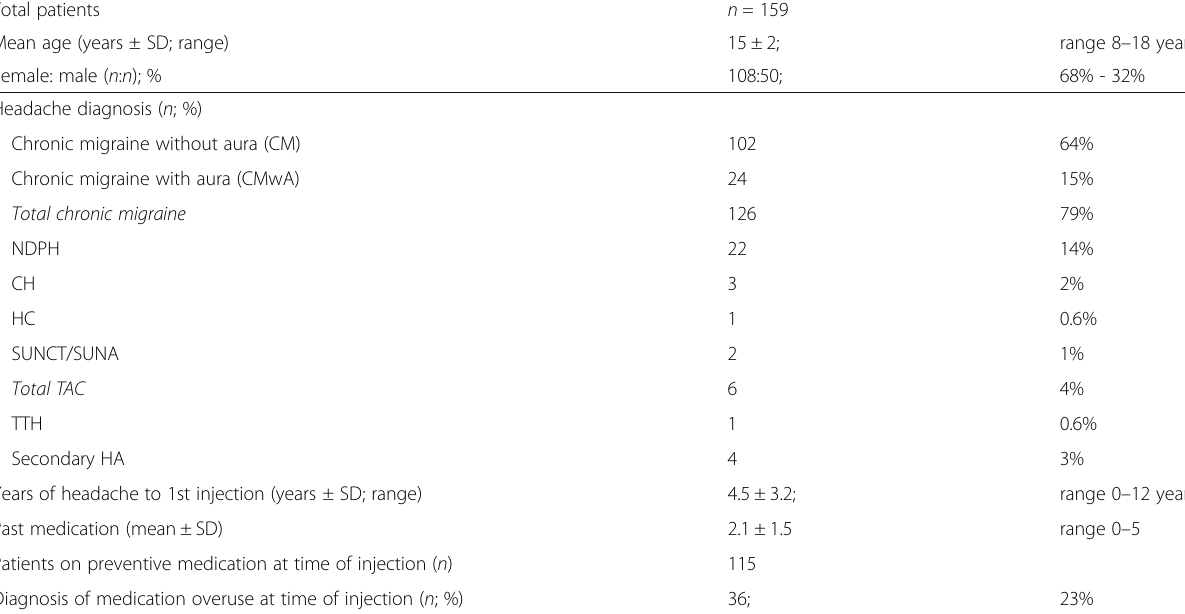
Table 1 Demographic characteristics of 159 patients treated with greater occipital nerve injection Total